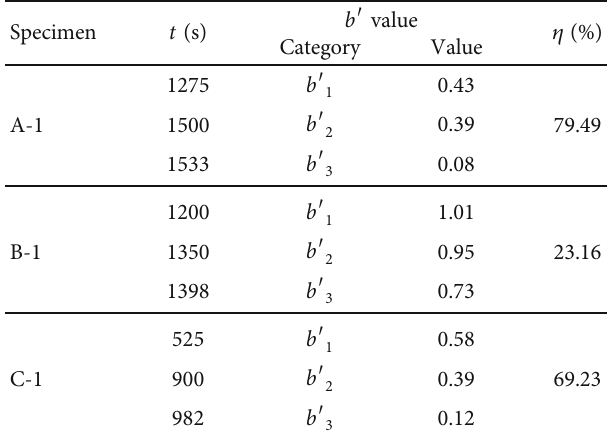
Table 2: The b ′ values of selected samples (units: s, %).